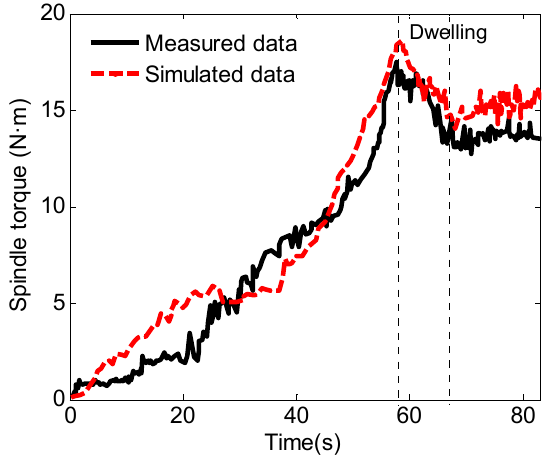
Figure 8. Spindle torque variation curve.